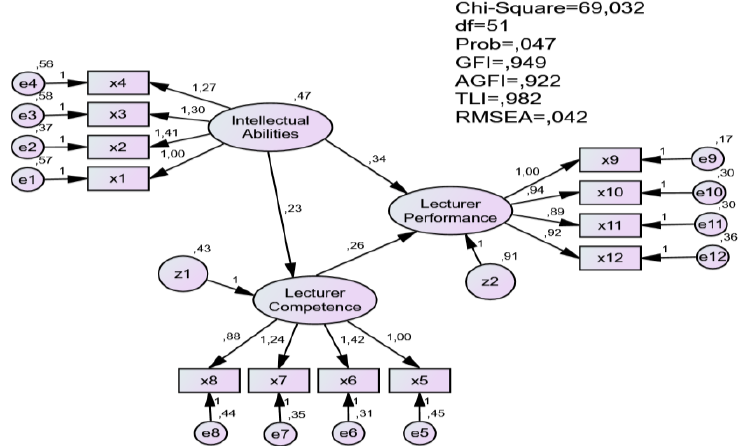
Figure 2. Model The Relationship Between Constructs